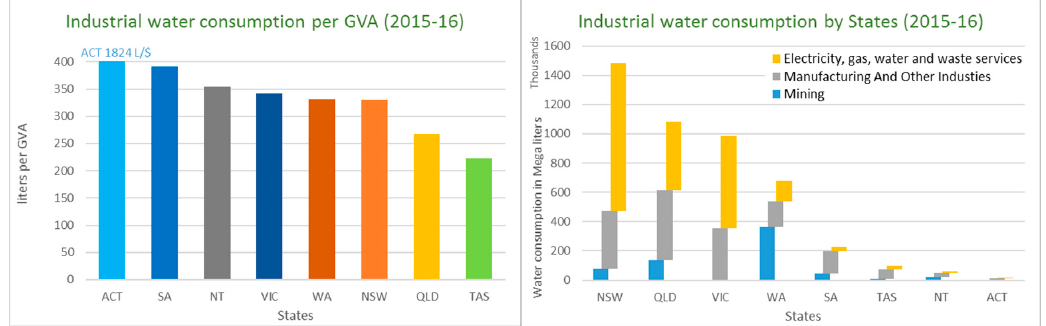
Figure 4. Industrial water consumption (ML) per industry and per Gross Value Added (GVA) excluding agriculture (thousand $) by each state (2015–2016) on left and total consumption by each sector on right (Data source: Australian Bureau of Statistics, 2017).